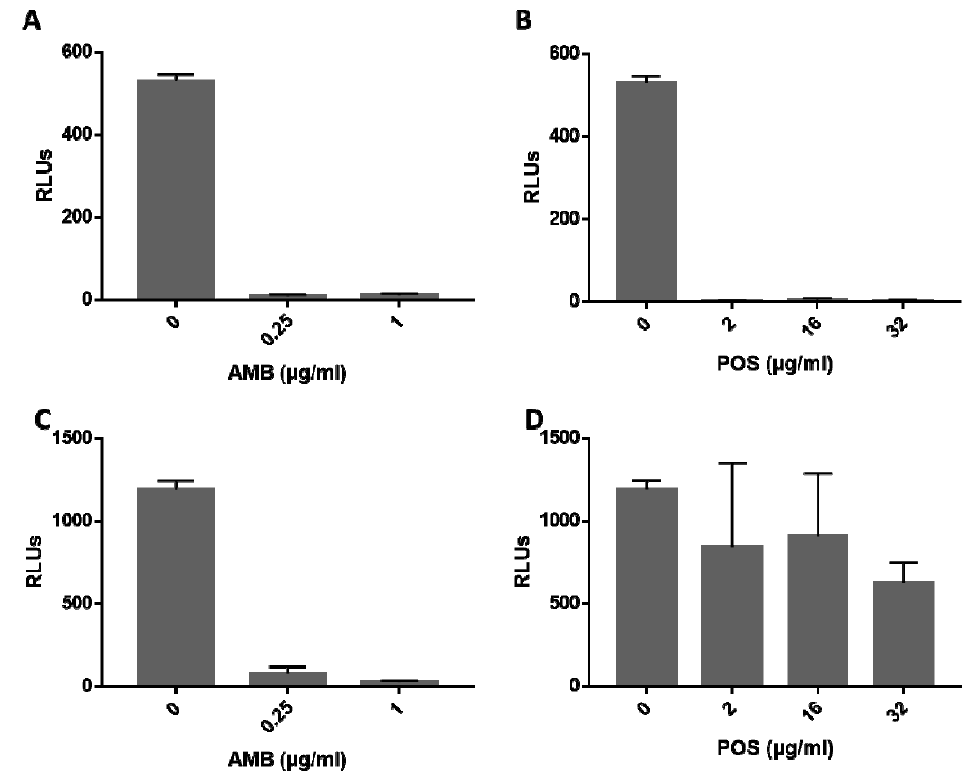
Figure 4. Graphical analysis of drug efficacy by detection of light emission. Luminescence was measured by a plate reader in wells containing 2 × 10 5 spores/mL of R7B_luc grown in YNB in the presence of amphotericin B (AMB) ( A ) or posaconazole (POS) ( B ), and with AMB ( C ) or POS ( D ) added to hyphae, respectively. Light emission was detected after 24 h of incubation ( A , B ) and subsequent luciferin (1:5, Roche) addition. Pre-grown cultures (16 h) were further incubated for 4 h once antifungals were added ( C , D ). Average values from three independent wells are given, error bars represent standard deviation.